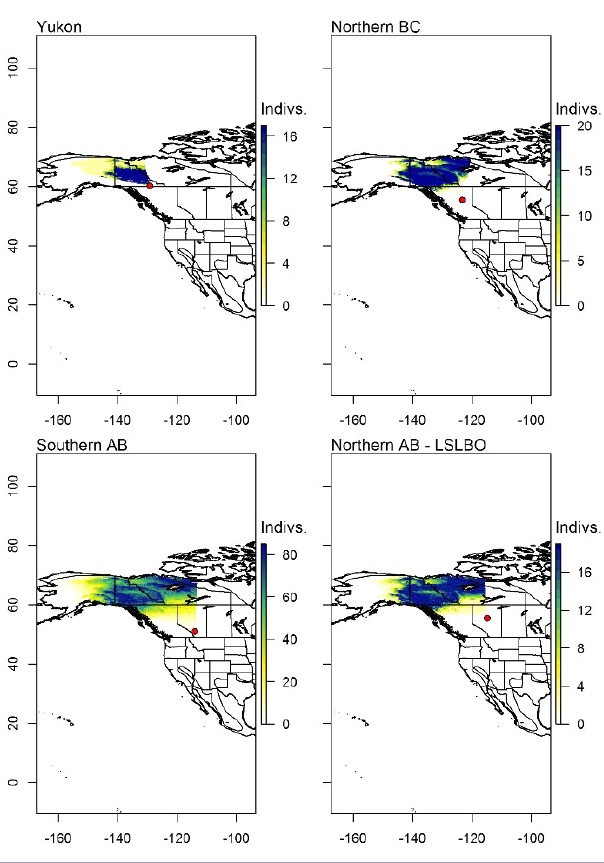
Fig. 5 . Probable origins of Yellow Warblers ( Setophaga petechia ) during fall migration. Red dots indicate locations of Canadian Migration Monitoring Network stations used in the analysis. Scales indicate the number of individuals that were isotopically consistent with similarly colored pixels in the map